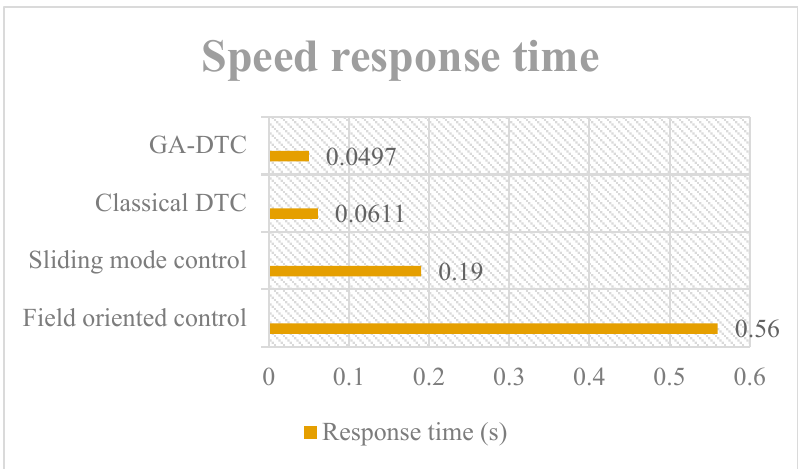
Figure 17. Histogram of various responses time of different strategies applied to the DFIM. Table 4. Performance measures of classic DTC and GA–DTC .